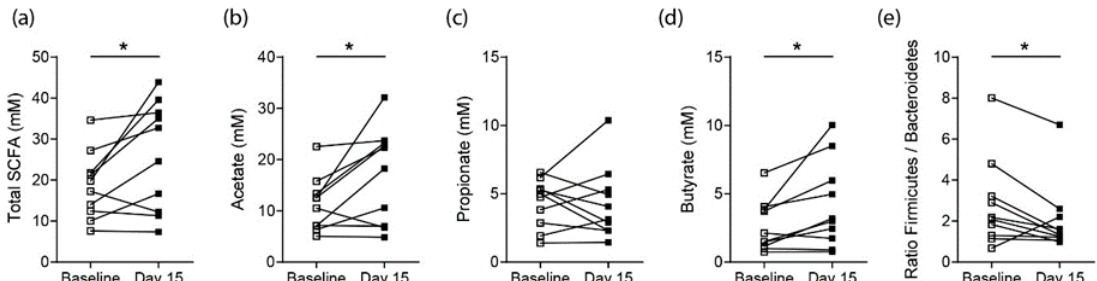
Figure 1. Short-term 15-day high-fiber diet supplementation in healthy controls ( n = 10) increases SCFA levels. ( a ) Total SCFA levels in stool samples at baseline and day 15 following high-fiber supplementation; Individual ( b ) acetate, ( c ) propionate and ( d ) butyrate stool concentrations of healthy controls; ( e ) Gut microbiota Firmicutes-to-Bacteroidetes ratio based on 16S rRNA sequencing results. Statistical difference was determined by a paired Students t -test (Wilcoxon matched-pairs signed rank test). * = p < 0.05; ** = p < 0.01; *** = p < 0.001.